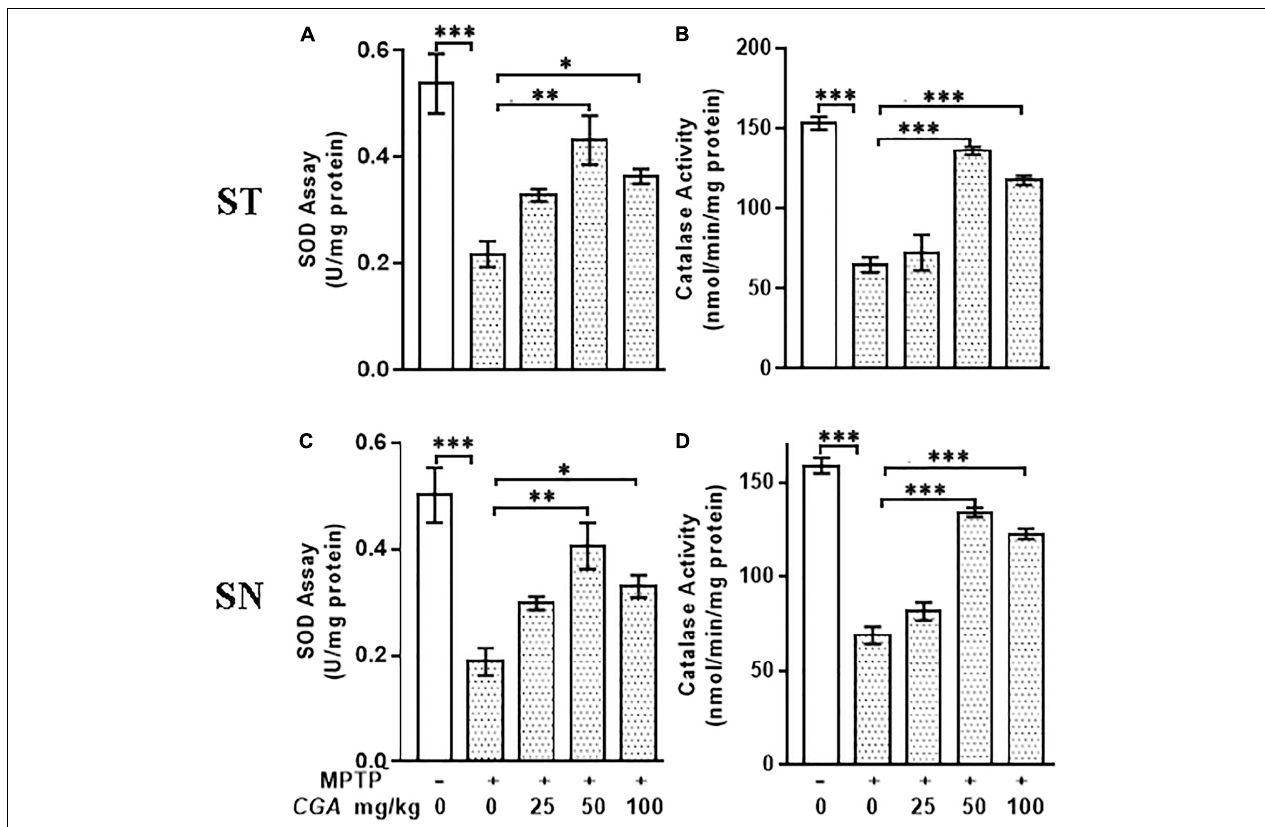
FIGURE 4 | Estimation of activity of SOD and catalase. (A–C) Superoxide dismutase (SOD) and (B–D ) catalase (CAT) activities measured in striatum and substantia nigra regions of the brain. MPTP injection caused significant increase in SOD and CAT activities in MPTP mice compared with the control group. CGA treatment in MPTP group increases SOD and CAT activities compared with the MPTP-injected animal group. Values are expressed as mean ± SEM ( n = 6). ∗ p < 0.05, ∗∗ p < 0.01, and ∗∗∗ p < 0.001. CGA, chlorogenic acid; MPTP, 1-methyl-4-phenyl-1,2,3,6-tetrahydropyridine; SOD, superoxide dismutase; CAT, catalase; SEM, standard error of